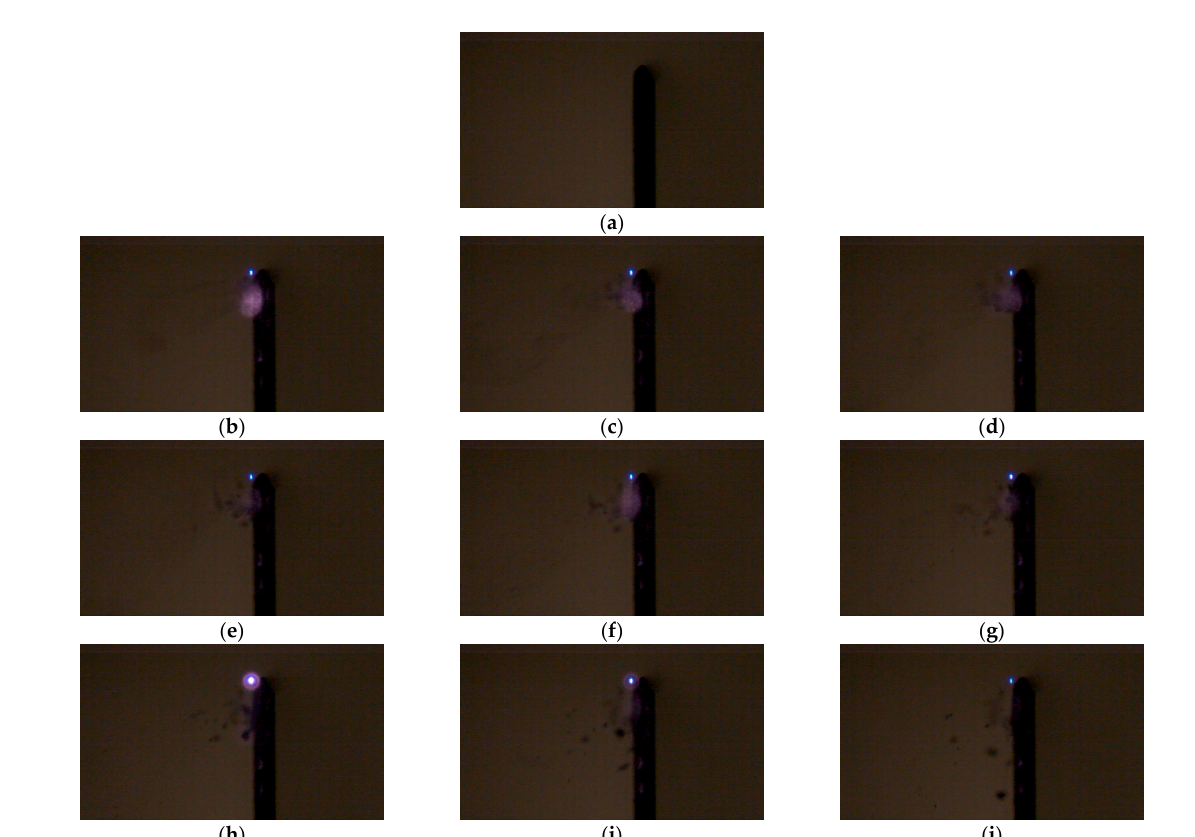
Figure 5. Observation of the particle removal process using a high-speed camera and black bar in glass substrate at ( a ) 0 ( b ) 1.5 ( c ) 3 ( d ) 4.5 ( e ) 6 ( f ) 7.5 ( g ) 9 ( h ) 10.5 ( i ) 12, and ( j ) 13.5 ms.